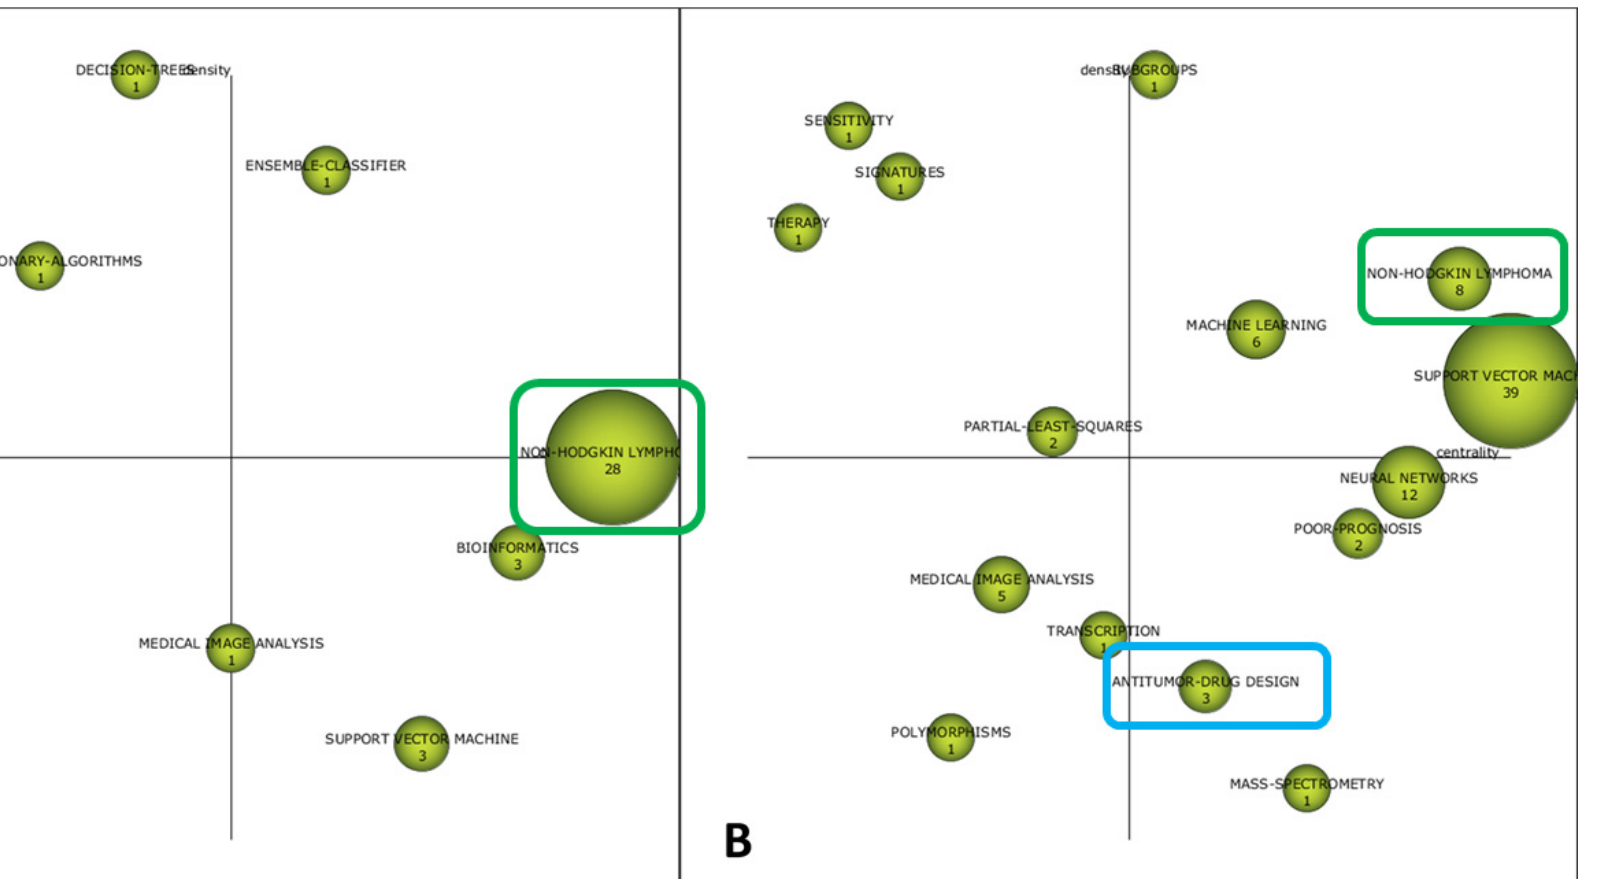
Figure 3. Two-dimensional space layout of research themes on AI and ML applications to diagnostic pathology in lymphoid neoplasms according to Callon ´ s density (vertical axis) and Callon ´ s centrality (horizontal axis) as shown by the SciMAT software. Research themes are categorized in Motor themes, Basic and Transversal themes, Emerging or Declining themes, and Highly Developed themes. Some themes that recur over time have been marked in the same color (blue and green). ( A ) Strategic diagram of the cognitive framework for the period 1990 to 2005. ( B ) Strategic diagram of the cognitive framework for the period 2006 to